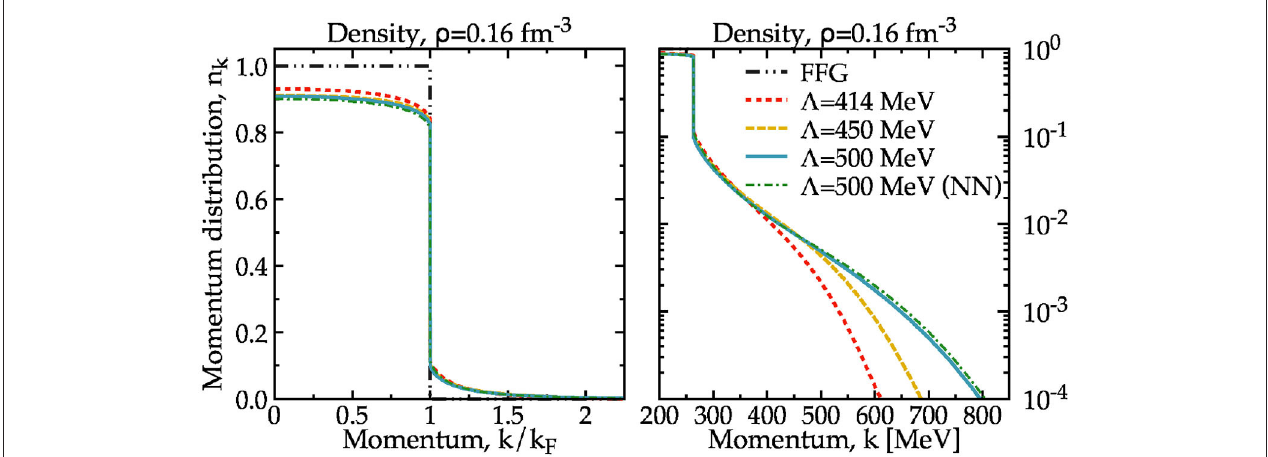
FIGURE 7 | Extrapolated zero-temperature momentum distribution obtained with different NN interactions for symmetric nuclear matter at ρ = 0.16 fm − 3 . The left panel shows the distribution on a linear scale as a function of k / k F . The right panel shows the same results on a logarithmic scale and as a function of momentum k , in units of MeV. The black dashed-double-dotted line corresponds to the free Fermi gas (FFG). The green dashed-dotted line is obtained from a calculation with the 3 = 500 MeV interaction without 3NFs. Other lines follow the convention of Figure 3